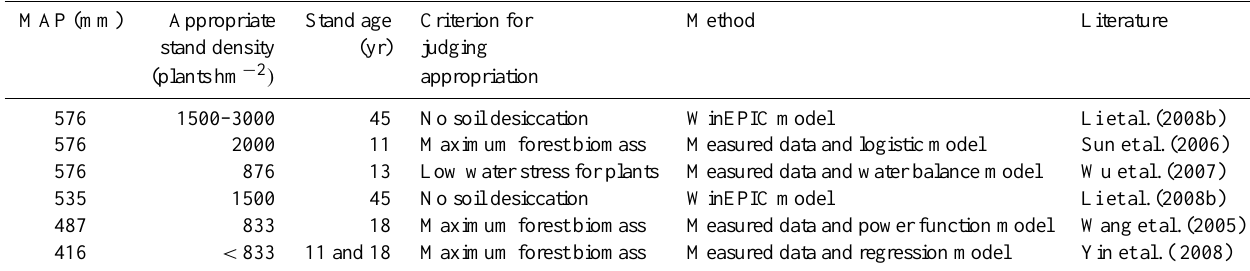
Table 3. Appropriate stand density for the Loess